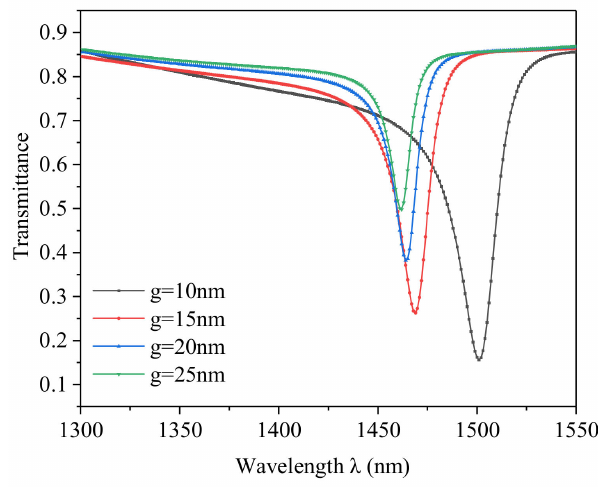
Figure 9. Transmission spectra of different coupling distance g